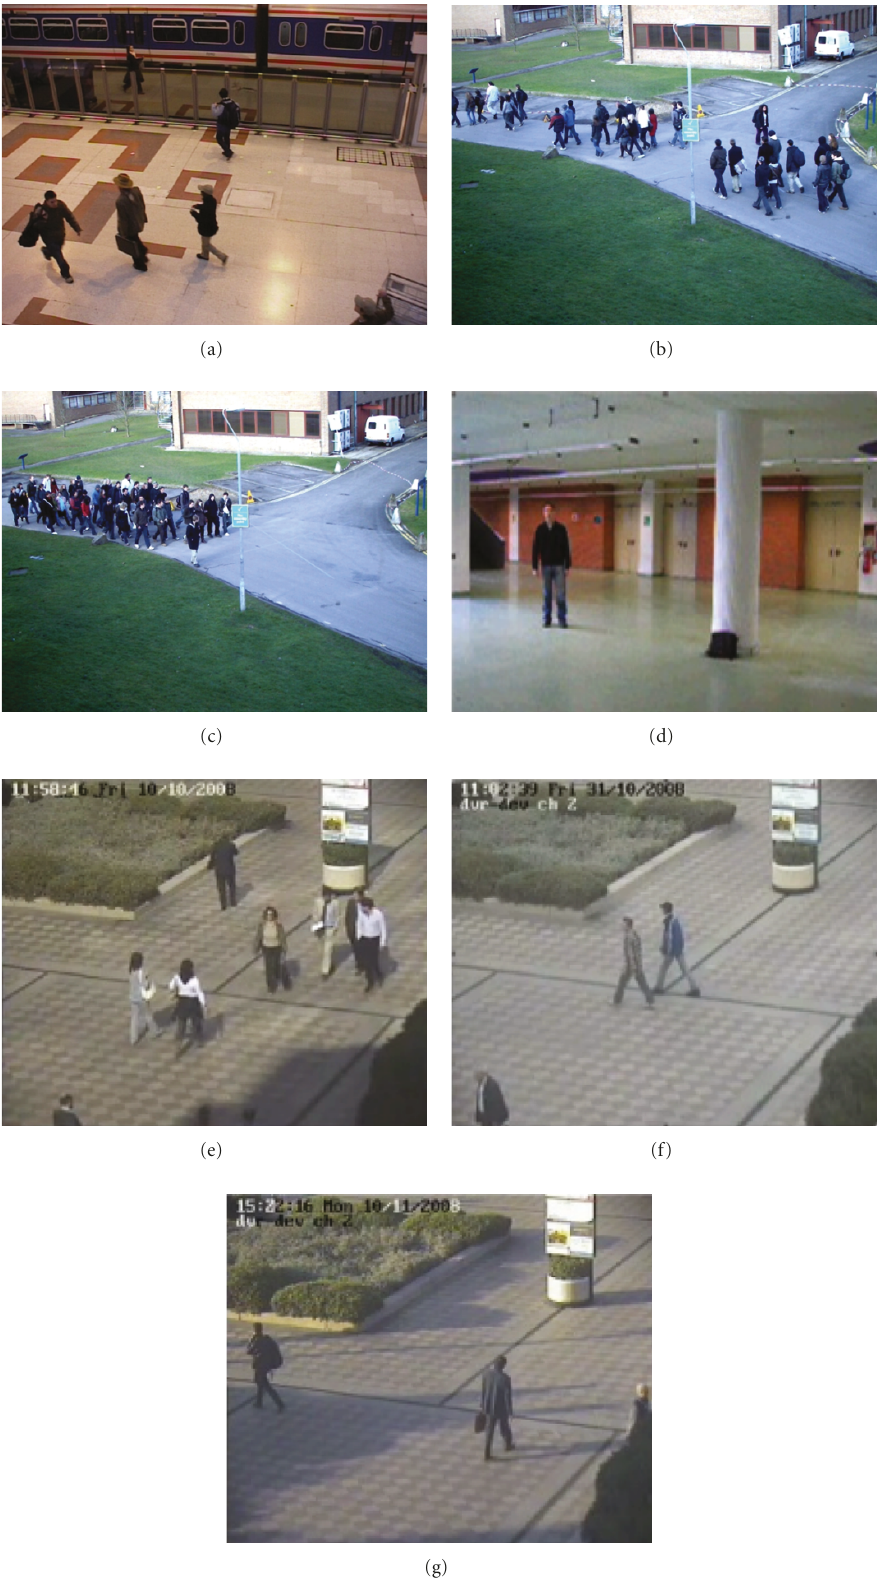
Figure 2: Sample of videos database. (a) PETS2006; (b) PETS2009-1; (c) PETS2009-2; (d) MSA; (e) MIVIA1; (f) MIVIA2; (g)